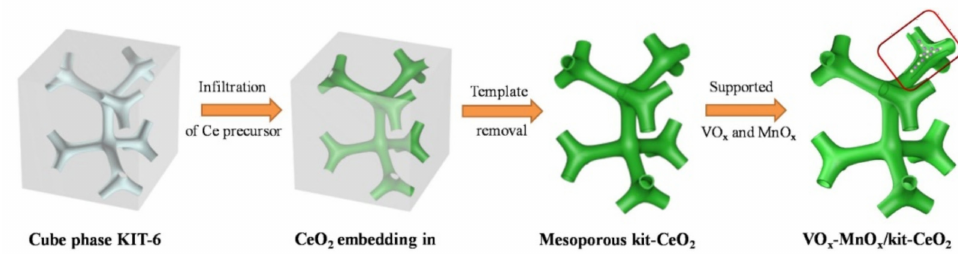
Figure 3. Schematic representation of the synthesis processes of mesoporous VO x -MnO x /CeO 2 . Reproduced with permission from Reference [30]; copyright (2020),